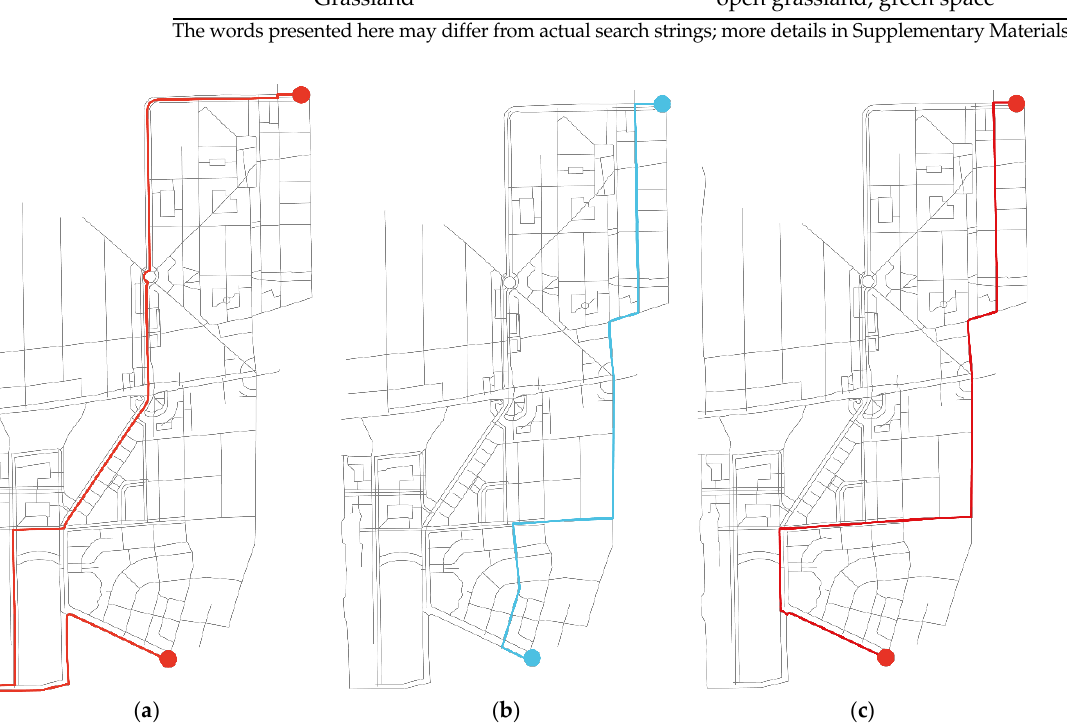
Table 2. Map feature and coding of potential formal and informal playspaces.